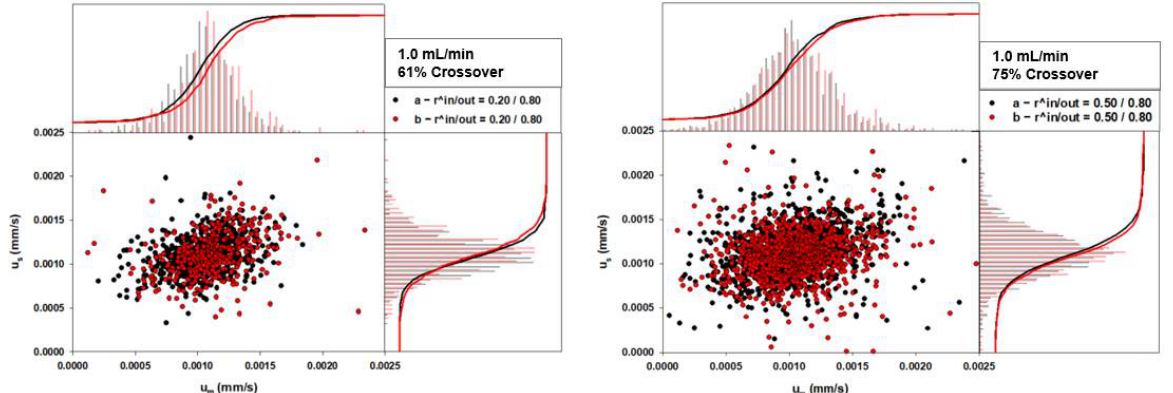
Figure 5. CTV results for the nonenriched (a, black) and enriched (b, red) streams that exit the QMS annulus for transport lamina conditions with V a > V a (cid:48) , resulting in a significant increase in magnetic mobility in the (b) outlet. However, this increase amounts to only 1.36 and 0.16 pgHb in MCH between the two plots.